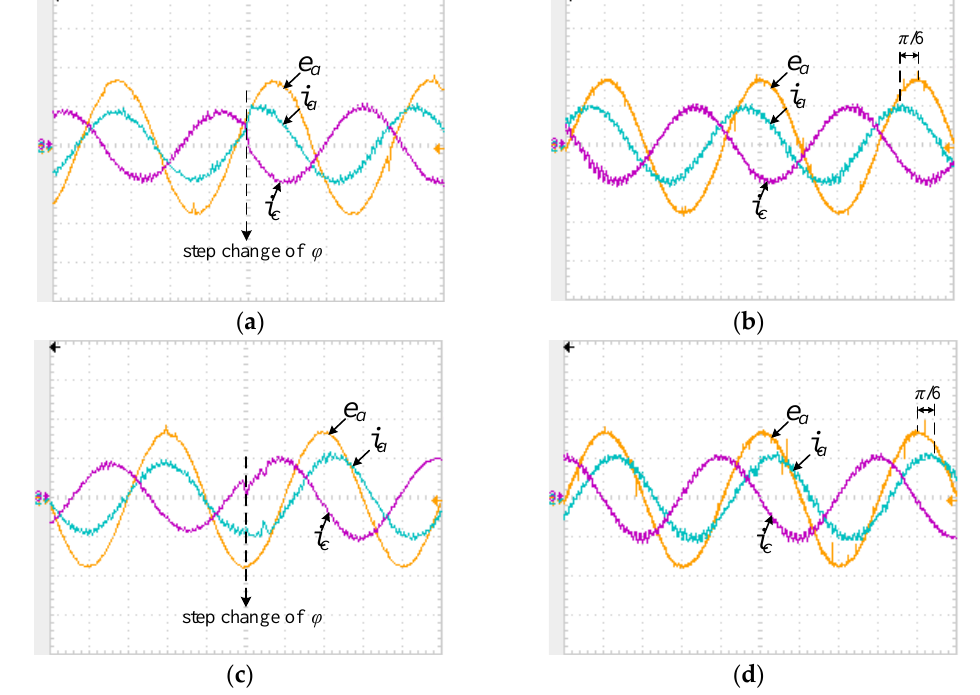
Figure 9. Performance of non-unity power factor conditions (20 V/div, 10 A/div, 5 ms/div): ( a ) Dynamic performance under the condition of φ is suddenly changed from 0 to π/6; ( b ) Steady-state performance under φ is π/6; ( c ) Dynamic performance under the condition of φ is suddenly changed from 0 to -π/6; ( d ) Steady-state performance under φ is -π/6.